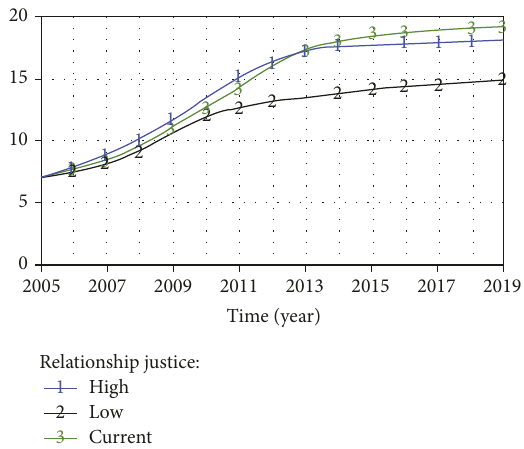
Figure 12: Influences of various trusts on relationship stock (RS).